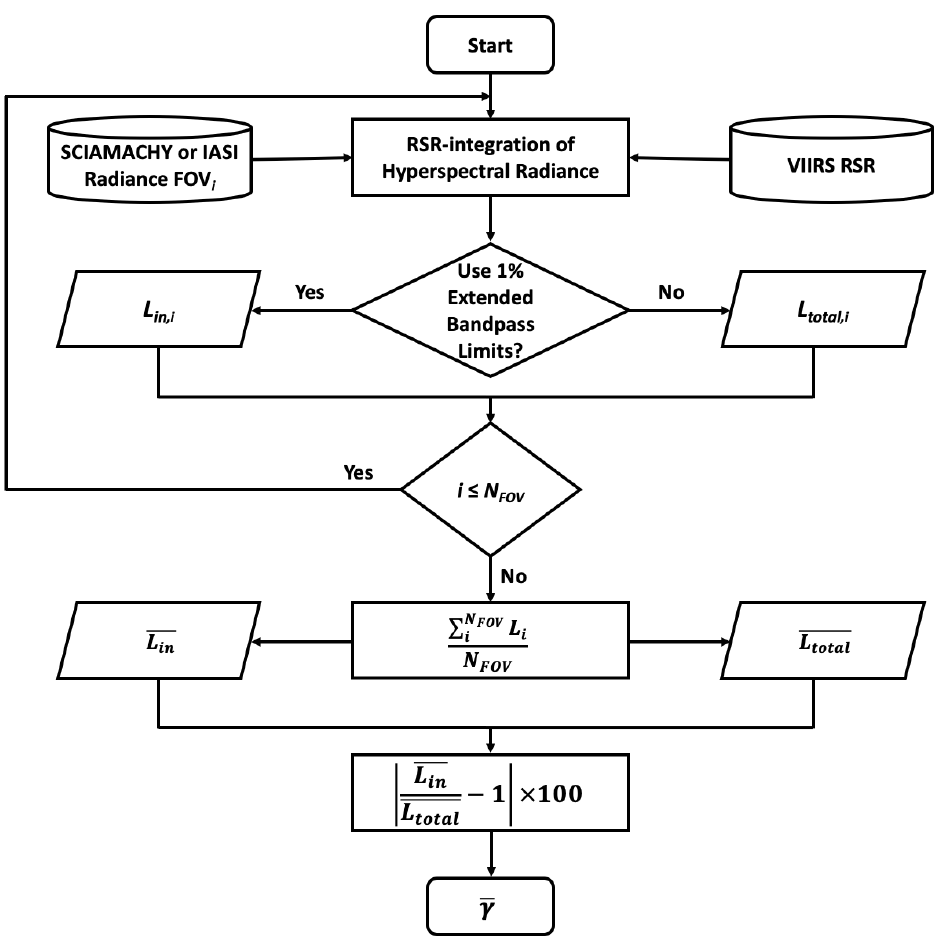
Figure 2. Flow chart of methodology for 𝛾̅ determination using i of N SCIAMACHY or IASI hyperspectral radiance fields of view (FOVs).